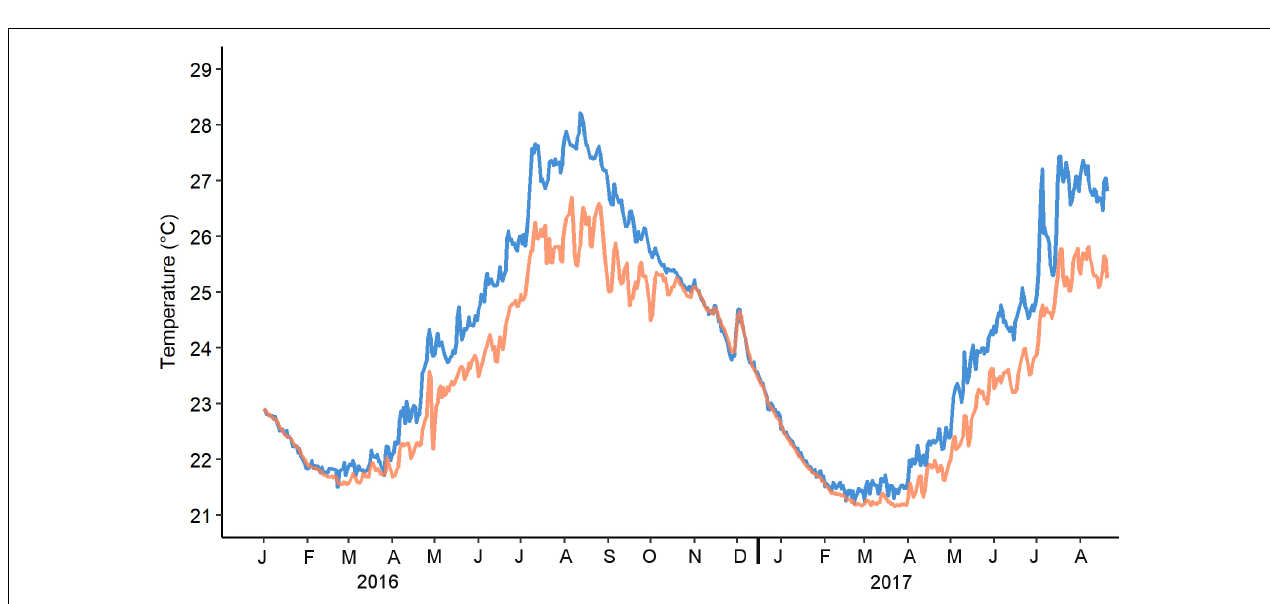
FIGURE 5 | Size frequency distribution of monthly diameters of oocytes in upper MCE (A) Ovabunda spp. and (B) Rhytisma fulvum fulvum in January 2016–August 2017. Above columns, number of oocytes measured each month derived from 1–5 colonies per month, three polyps per Ovabunda spp. colony and five per R. f. fulvum colony.